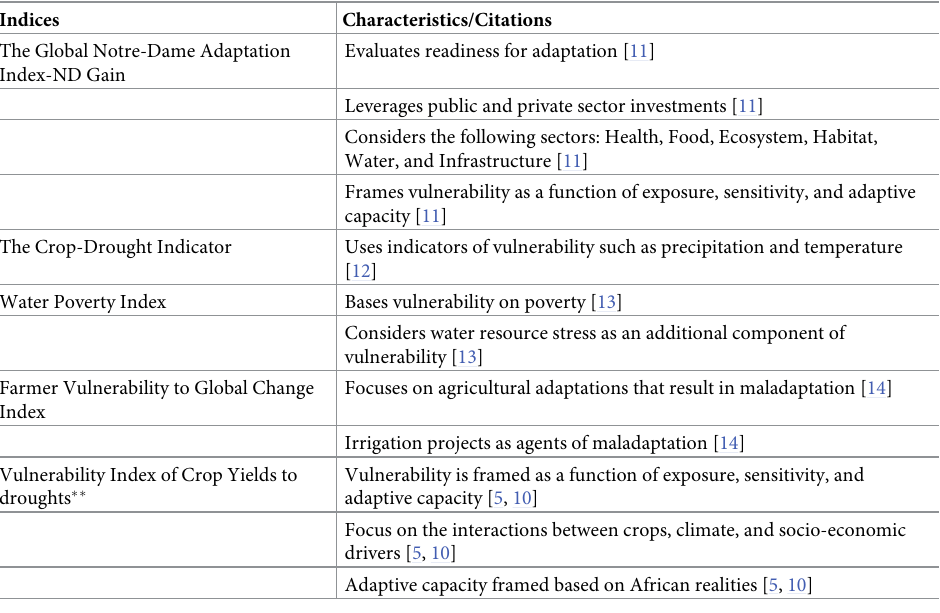
Table 1. Comparison of vulnerability